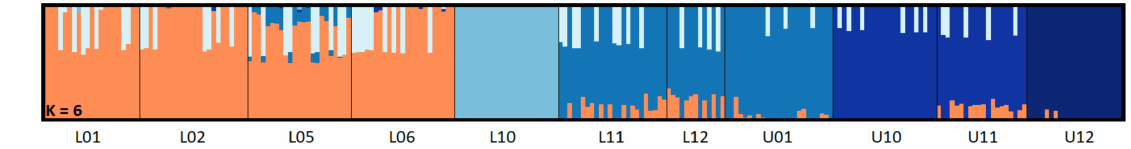
Figure 4. Barplots of population structure with K = 6 clusters in three-spined stickleback inferred by Bayesian analysis using fastStructure v1.0.